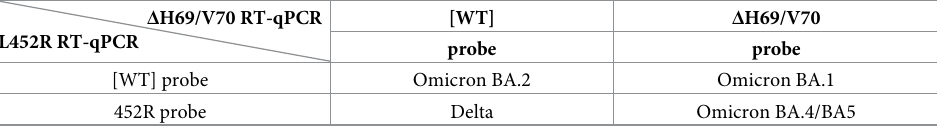
Table 3. SARS-CoV-2 variants and sub-lineages detected by the combination of Δ H69/V70 and L452R RT-qPCRs.